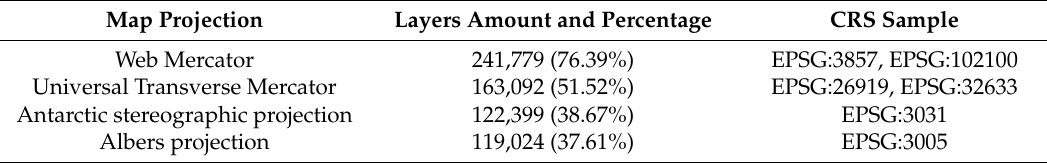
Table 3. Common map projections of widely-supported projected Coordinate Reference Systems